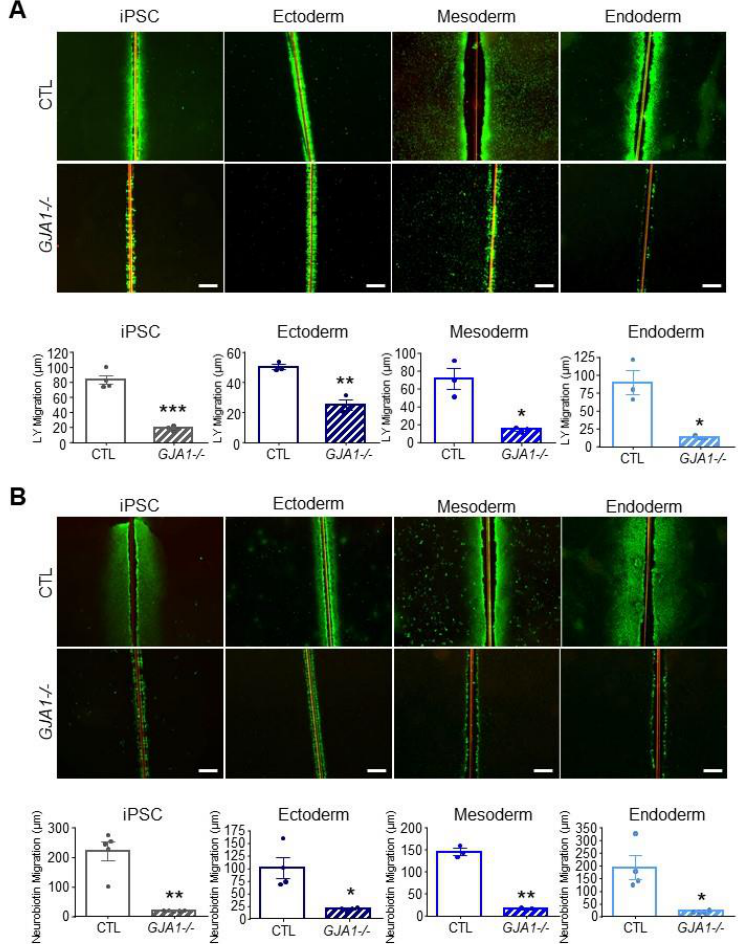
Figure 8. Gap junction coupling is lost in Cx43 knockout iPSCs and cells of each germ lineage. Scrape loading dye transfer assay of control and GJA1-/- iPSCs, ectoderm, mesoderm, and endoderm cells. ( A ) Representative fluorescence images of gap junction permeable dye Lucifer yellow (LY) or ( B ) neurobiotin. Scale bars = 200 µ m. Data represent the standard error of the mean of 3–5 independent experiments. * p < 0.05; ** p < 0.01, *** p < 0.001 compared to control cells.